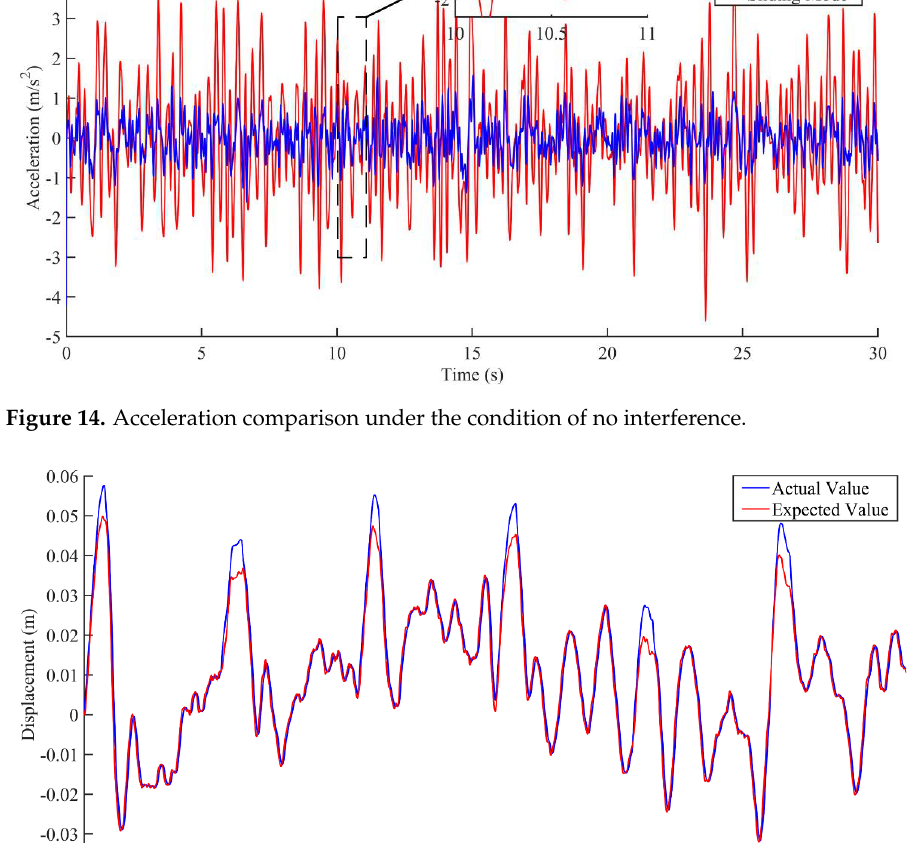
Figure 15. Comparison of actual and expected vibration displacement based on state feedback con- trol under the condition of interference.